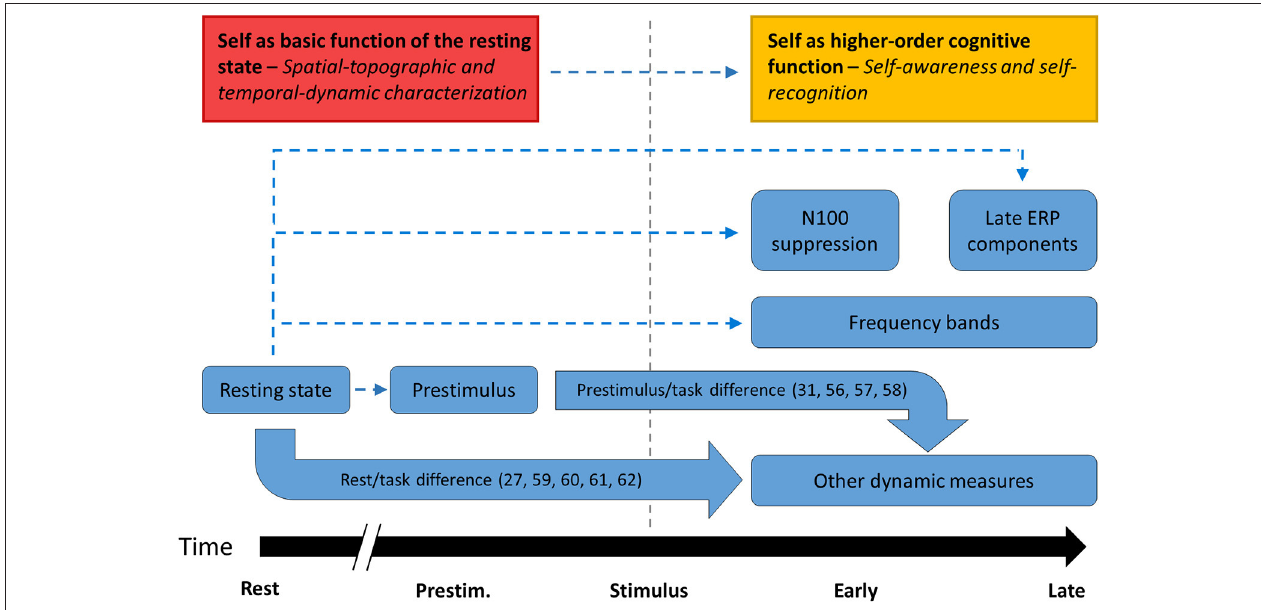
FIGURE 8 | Proposed relationships between empirical findings. The major groups of findings identified in this review. Thick, solid arrows indicate relationships that were studied empirically in the literature while thin, dashed arrows indicate relationships that the basic model of self proposes in order to unify separate findings in the